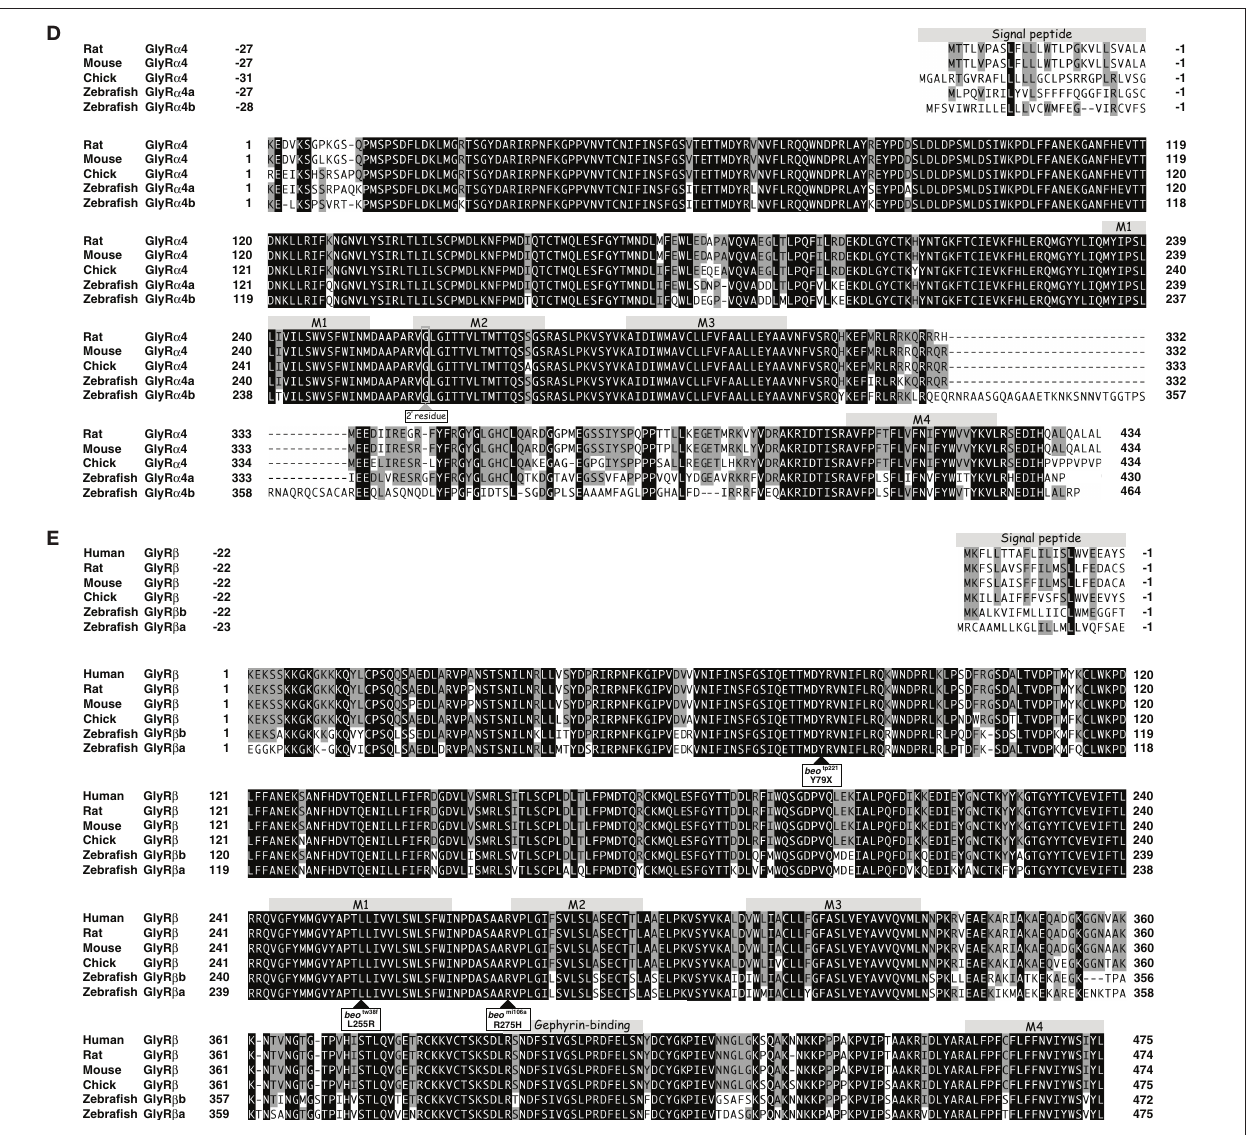
FIGURE 3 | Sequence alignments of zebrafi sh GlyR subunits with avian and mammalian counterparts. (D) Protein sequence alignment of rat (XP_346351), mouse (NP_034427), chick (XP_001232995) with zebrafi sh GlyR GlyR α 4a (GQ406229) and GlyR α 4b (AAH85599). (E) Protein sequence